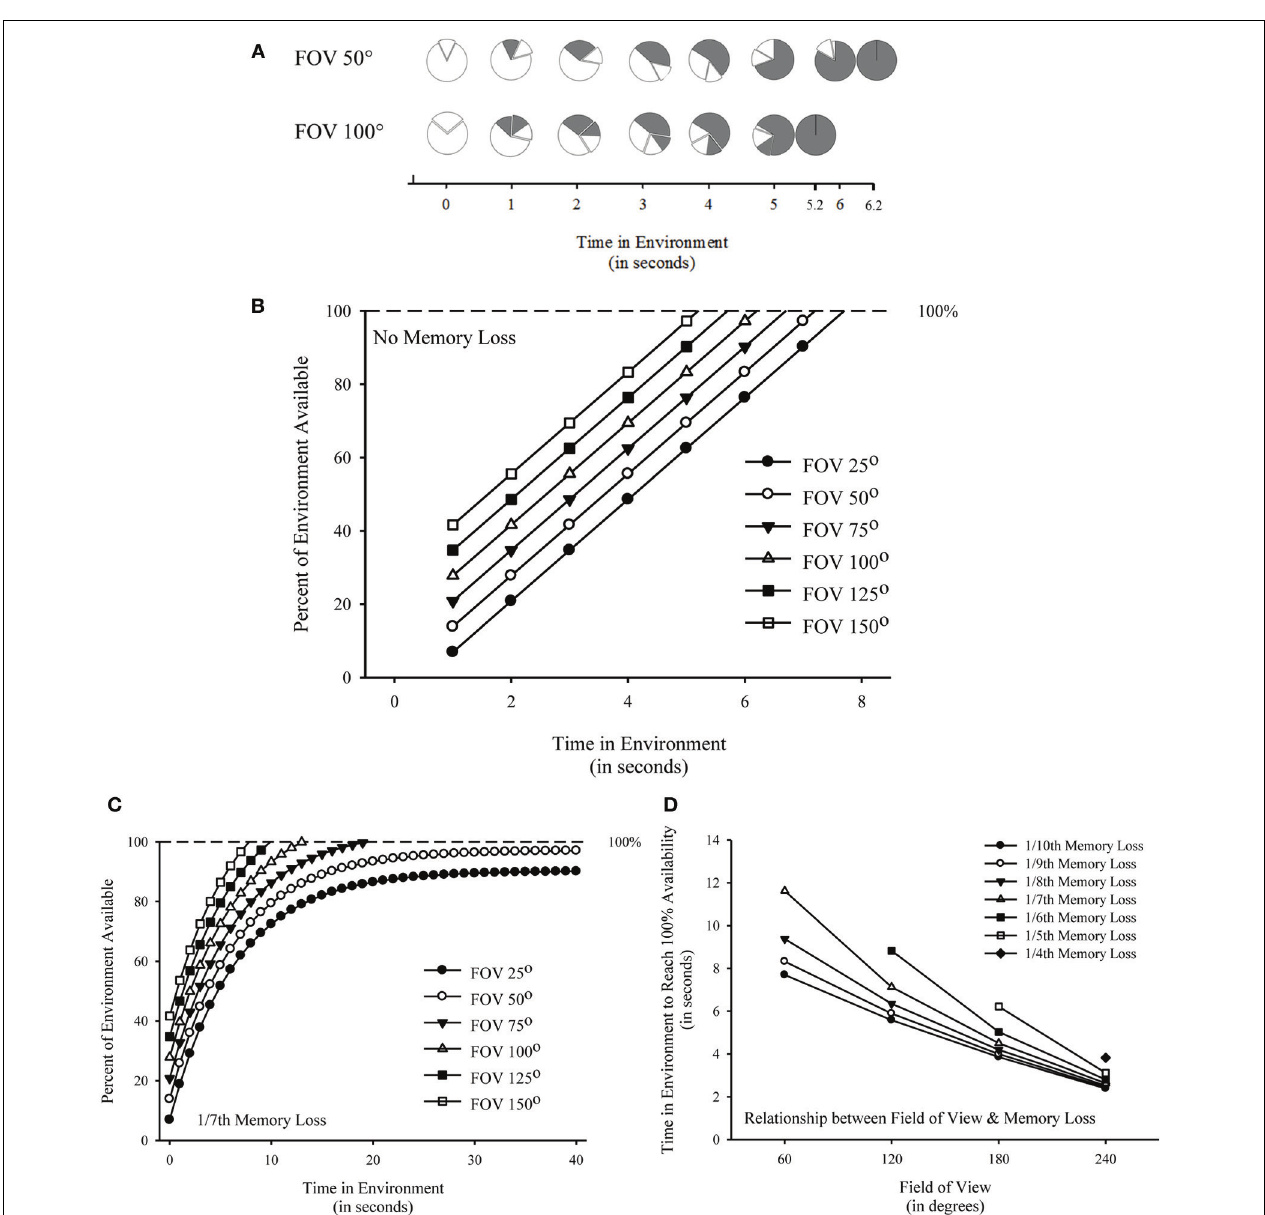
FIGURE 1 | (A) Theoretical illustration of percent of environment available by time in the environment assuming a fixed field of view at the centroid of a circular enclosure with a constant rate of rotation (i.e., 50 ◦ clockwise every 1.0s) and no loss in memory plotted for a field of view of 50 ◦ and a field of view of 100 ◦ . Exploded regions represent the current field of view. Filled regions represent the amount of environment previously viewed. Unfilled regions represent the amount of the environment that is not yet